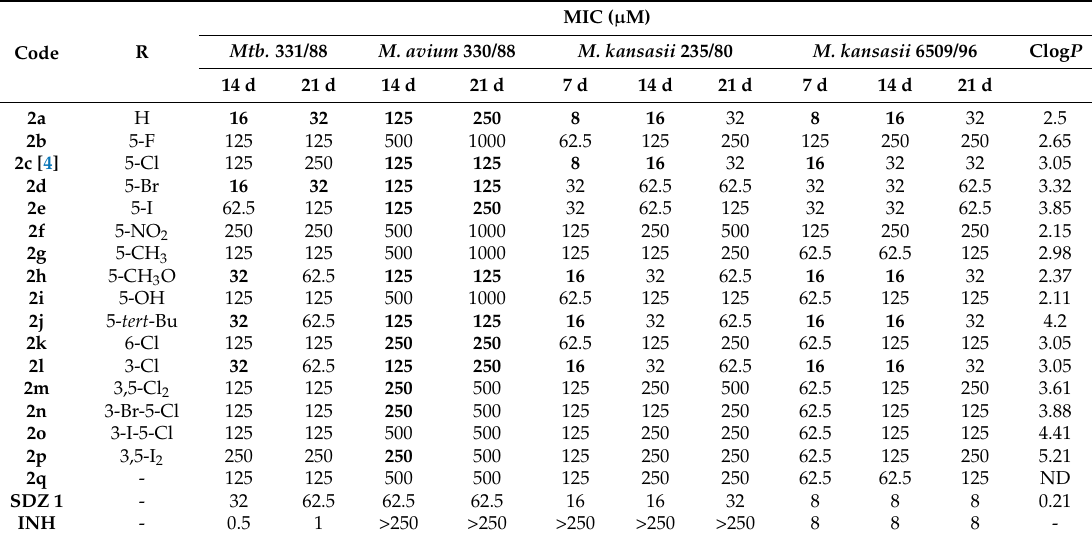
Table 2. Antimycobacterial activity of sulfadiazine derivatives 2